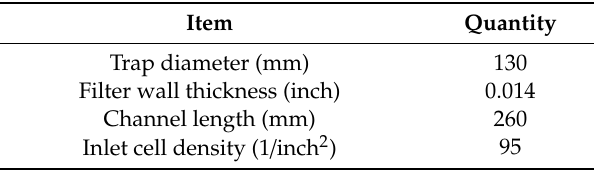
Table 4. Configuration parameters of DPF in GT-power.